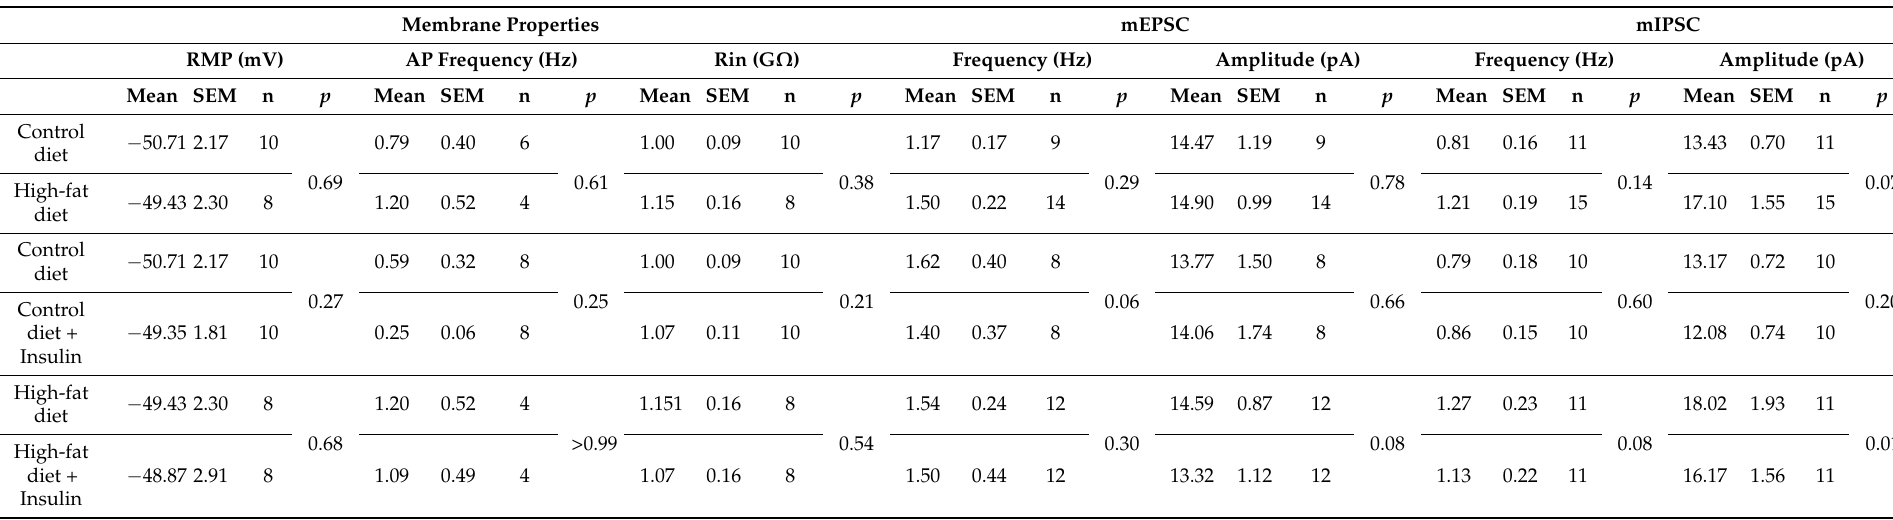
Table 1. Resting membrane potential, firing rate, and synaptic neurotransmission in VLM-projecting liver-related PVN neurons. Membrane